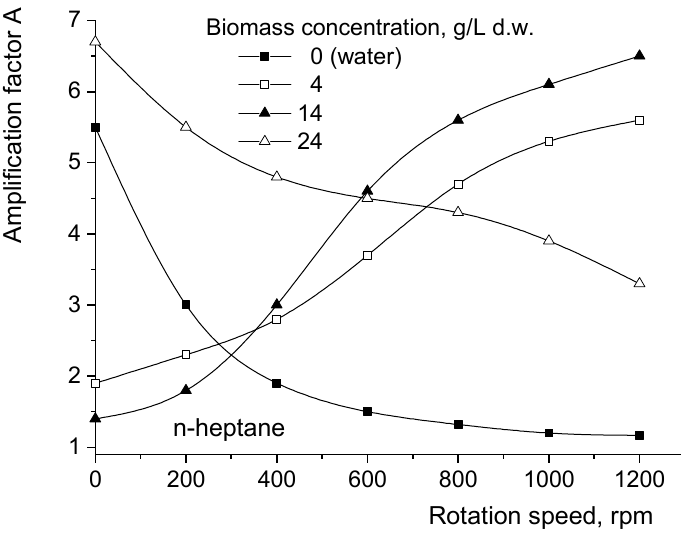
Figure 6. Influence of the impellers’ rotation speed on the amplification factor.